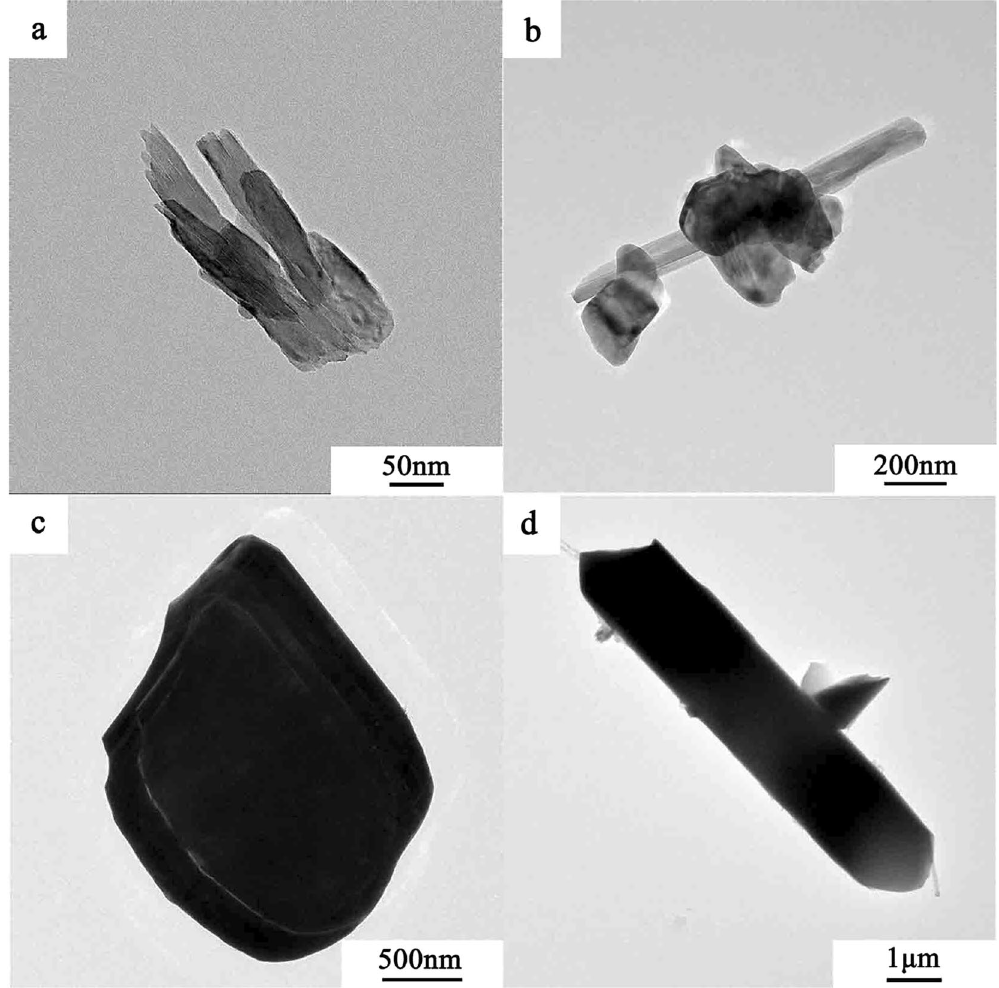
Figure 4. TEM images of α -MoO 3 synthesized at ( a ) 300 °C, ( b ) 400 °C, ( c ) 500 °C and ( d ) 600 °C.